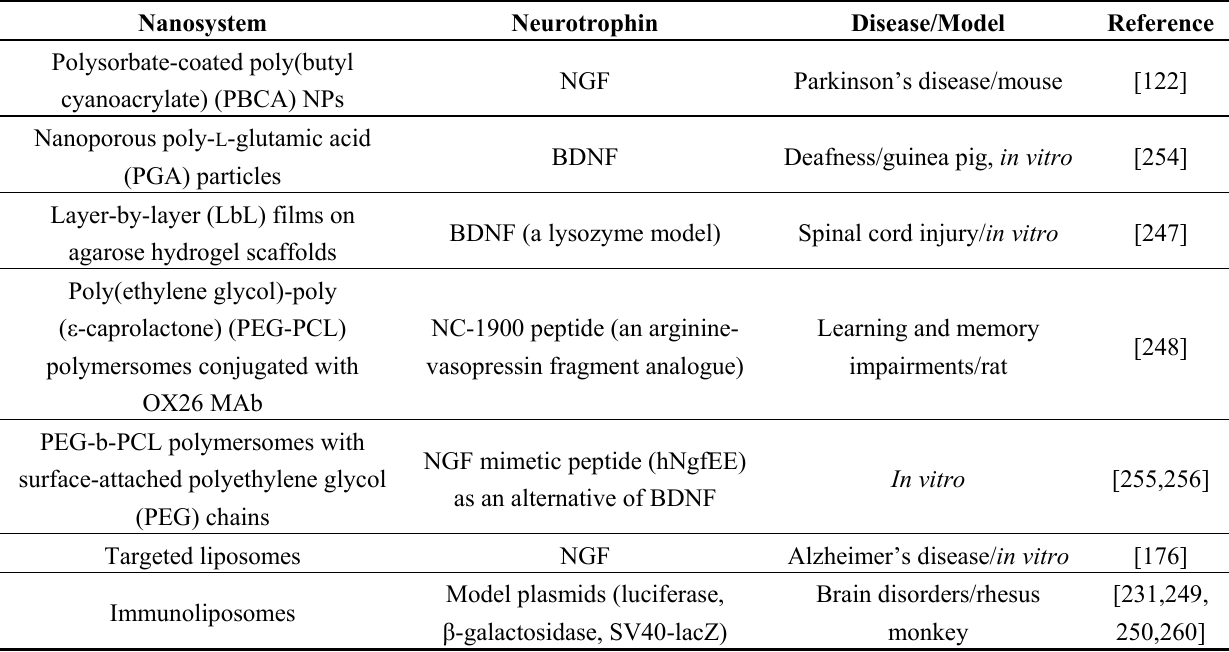
Table 2. Nanoscale carrier systems for neurotrophin